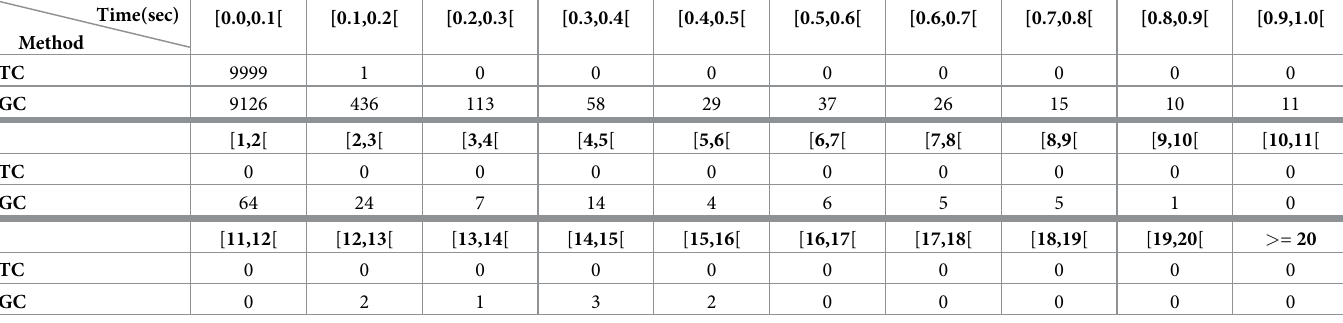
Confusion matrices. We compare the results on structural similarities with MCES on MG, on GC and TC on the 124, 750 pairs of 500 molecules in M . S A confusion matrix is a performance measurement used in machine learning classification [30]. We use it to measure whether the three methods give or not the same results. Table 3 gives the confusion matrix of MG and TC. Each row of the matrix represents the number of pairs of molecules in MG with a value of similarity that is distributed in different columns according to their value in TC. The confusion matrix between ECFP4 and FCFP4 shows a strong correlation. Furthermore, the matrices of GC with Tanimoto on Daylight fingerprint and circular fingerprints show sim- ilar results (in S2 Table). In the rest of the paper, TC is computed with Daylight fingerprint only. We use M to evaluate a correlation between GC, TC, and MG. In Fig 5, the map indicates S by a dot each experiment according to the similarity value obtained for each measurement Table 2. Pre-processing time (in seconds) of graphs of cycles for GC and fingerprints for TC.